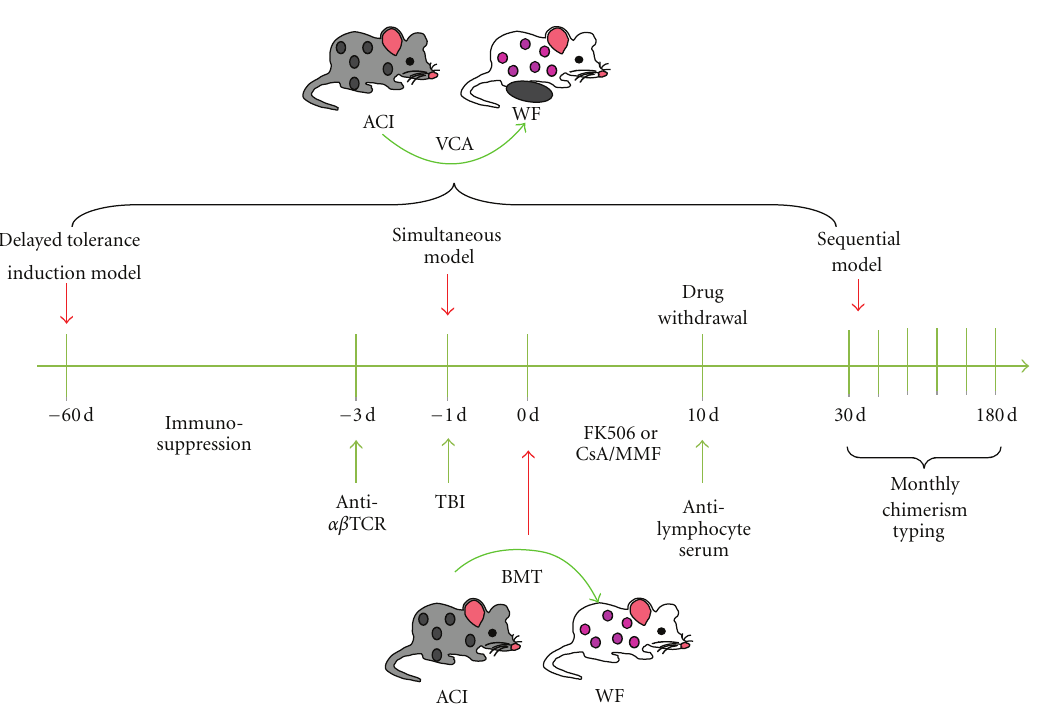
Figure 1: Schema for inducing VCA